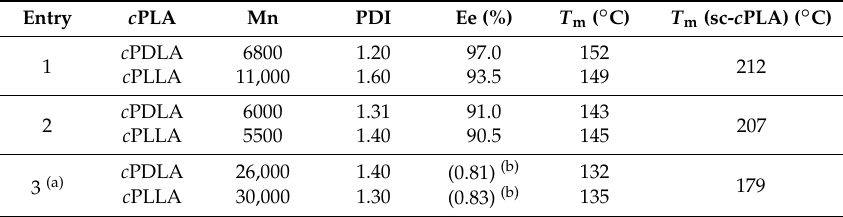
Table 2. DSC measurements of the stereocomplex of c PLA.